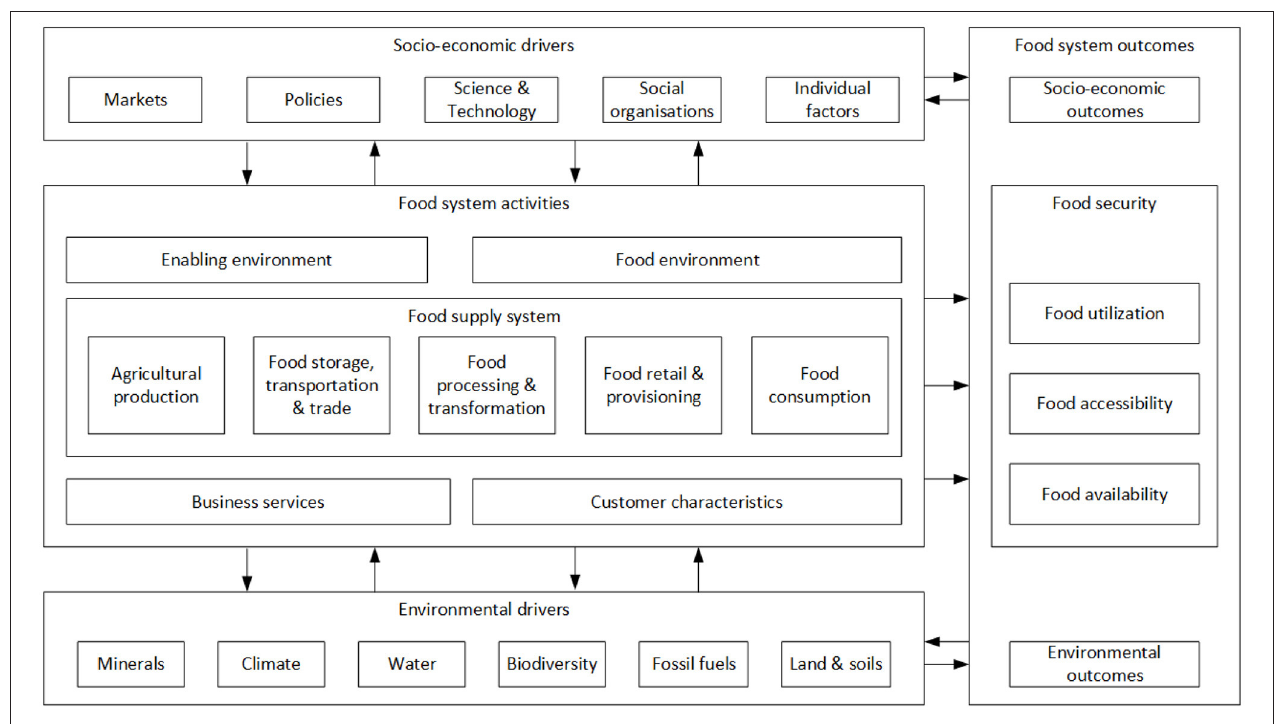
FIGURE 1 | Food systems framework. Source: van Berkum et al. (2018).